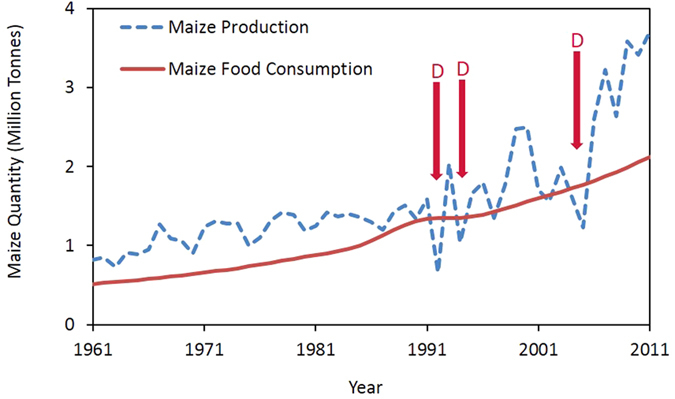
Malawi’s historical national maize production67 and maize food consumption.Due to high population growth35, and the prevalence of high maize consumption in the Malawian diet (approximately 382g/capita/day52), national maize requirement has increased steadily over the last few years. ‘D’ indicates notable drought years).